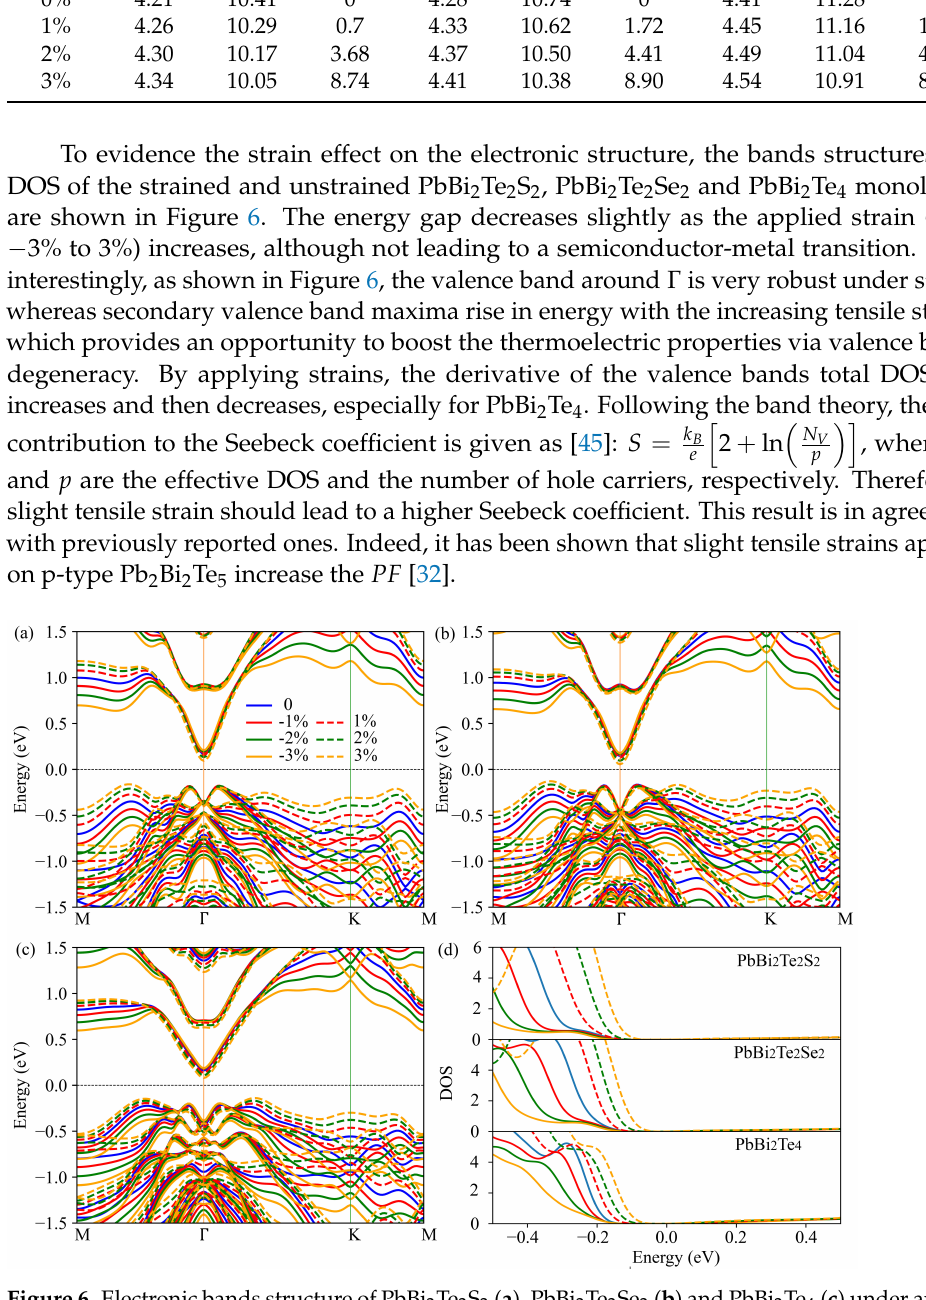
Figure 6. Electronic bands structure of PbBi 2 Te 2 S 2 ( a ), PbBi 2 Te 2 Se 2 ( b ) and PbBi 2 Te 4 ( c ) under applied strain and their corresponding total DOS ( d ). The τ -scaled PF of the PbBi 2 Te 2 S 2 , PbBi 2 Te 2 Se 2 and PbBi 2 Te 4 monolayers at 500 K as